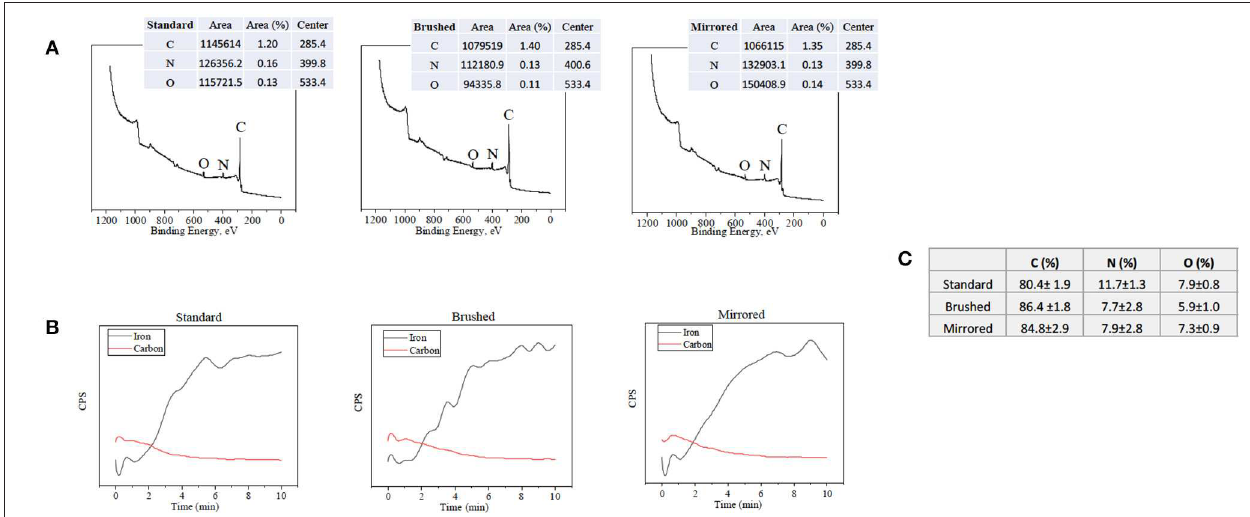
FIGURE 2 | XPS data used for surface characterization. (A) Surface survey on standard, brushed, and mirrored surfaces used for atomic composition with labeled peaks and (B) corresponding depth profiles used for thickness measurements. (C) Table summarizing atomic composition of the coatings on each surface finish.